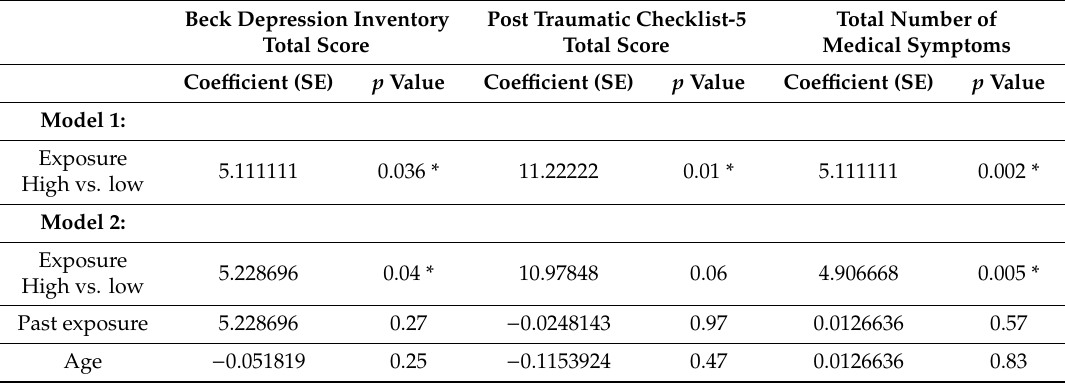
Table 3. Predictors of depression, anxiety, and number of medical symptoms outcome 3 to 8 weeks post hurricane landfall (Time